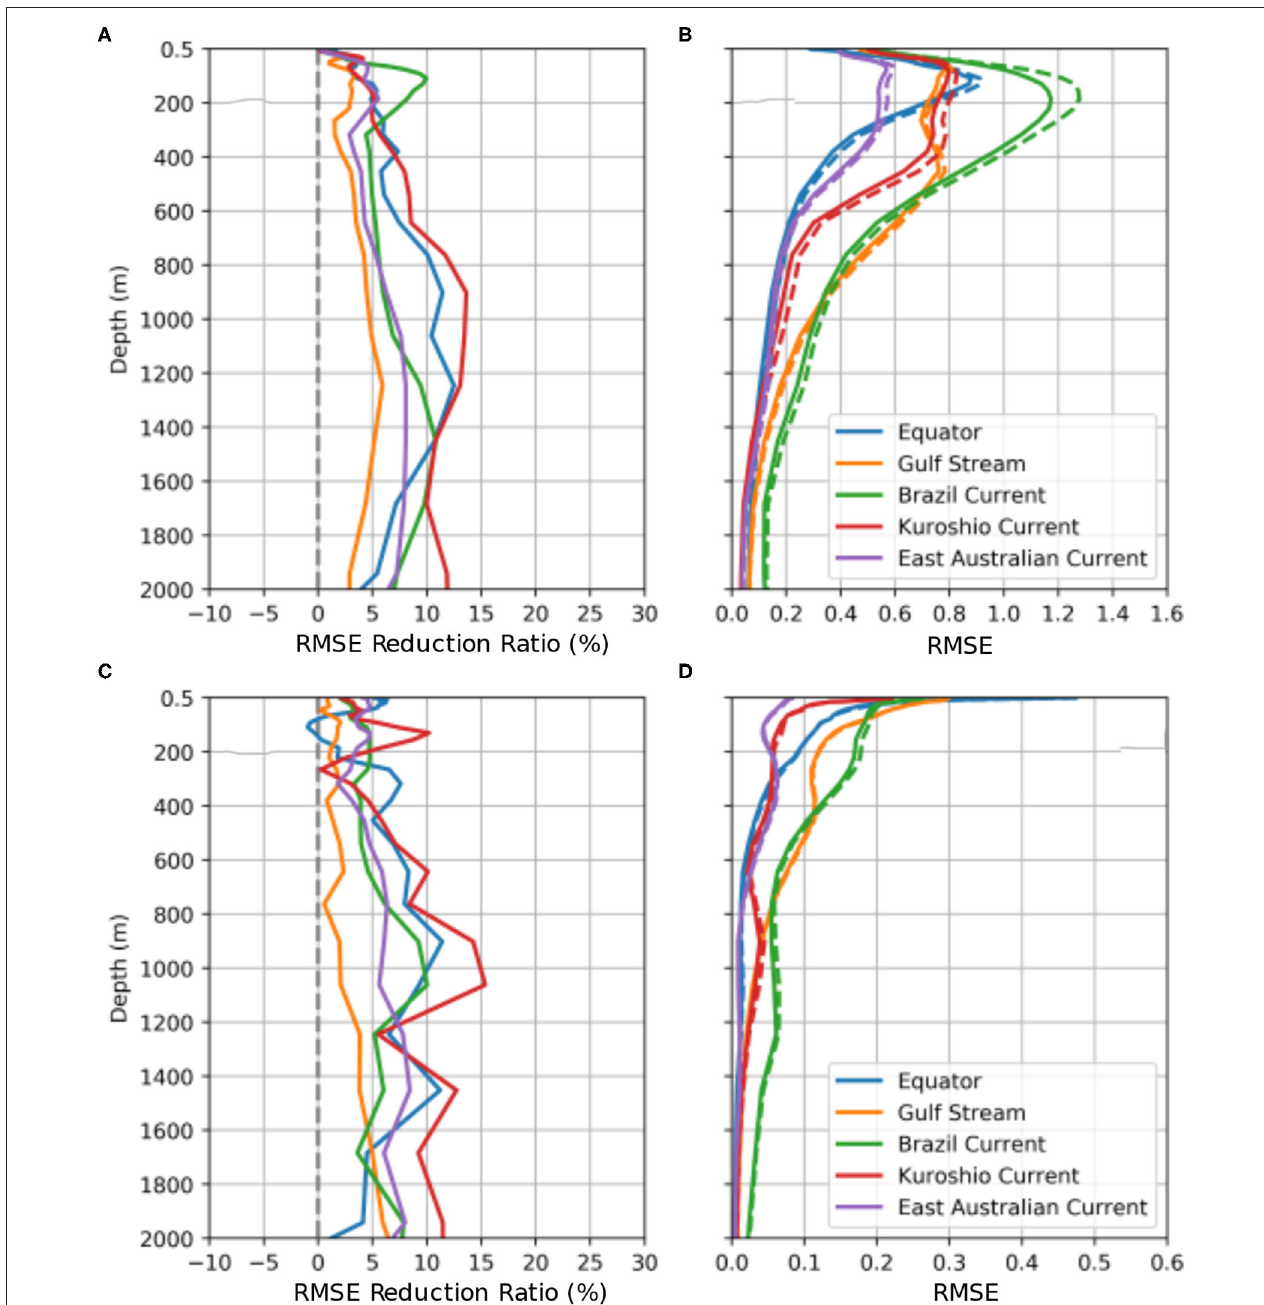
FIGURE 7 | RMSE reduction (as defined by Equation3) and RMSE of WBC_ARGO2X-NR compared to Backbone-NR in five geographical regions: (A) temperature RMSE reduction ratio, (B) temperature RMSEs of WBC_ARGO2X (solid lines) and Backbone (dashed lines), (C) salinity RMSE reduction ratio, and (D) salinity RMSE of WBC_ARGO2X (solid lines) and Backbone (dashed lines). Blue: Equator, orange: Gulf Stream, green: Brazil Current, red: Kuroshio Current and purple: East Australian Current.